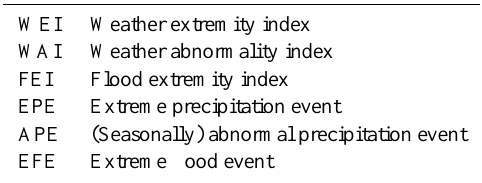
Table 1. Acronyms for proposed indices and studied hydrometeo- rological